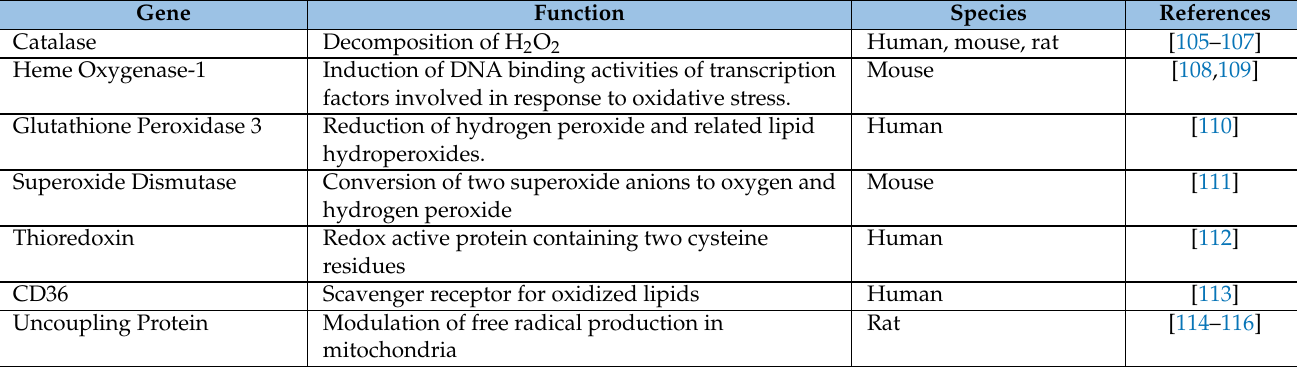
Table 3. Main antioxidant genes under transcriptional control of